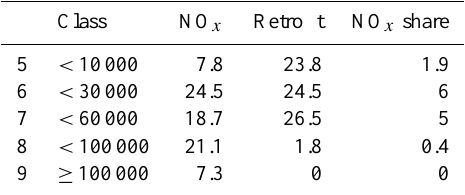
Table 1. Ratio of NO x emissions per size class and ships built be- tween 1990 and 2000 (retrofit) and the share of these ships in total NO x emissions in %.